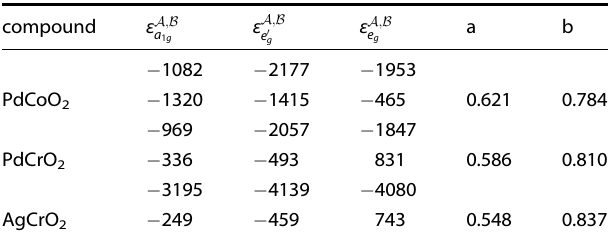
Table 2. DFT crystal- fi eld levels on A ( fi rst row) and B (second row) site in the investigated delafossites, as well as orbital coef fi cients a , b on the B site. All energies in